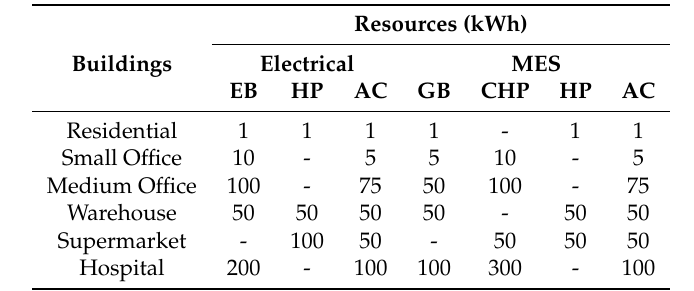
Maximum power of resources: only electrical buildings vs. Multi-Energy System (MES) buildings.